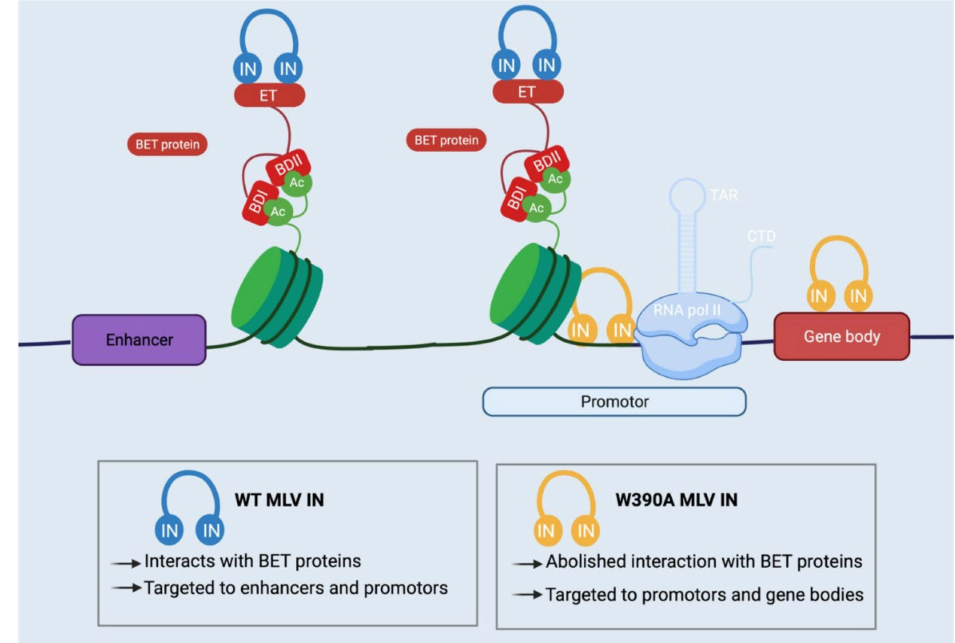
Figure 4. Integration pattern of wild–type (WT) and W380A mutant murine leukemia virus (MLV) in vivo. Bromodomain and extra–terminal motif (BET) proteins tether the wild-type (WT) MLV pre–integration complex (PIC) to enhancers and promoters. In contrast, integration of the W390A mutant MLV PIC, which cannot interact with BET, is redirected toward promoters and gene bodies. Oncogenesis by WT MLV IN is probably provoked by integration near enhancers and promotors, which results in the overexpression of cellular oncogenes, while the W390A mutant’s integration in oncogene bodies induces insertional mutagenesis [55] (Figure created with Biorender.com on 17 December